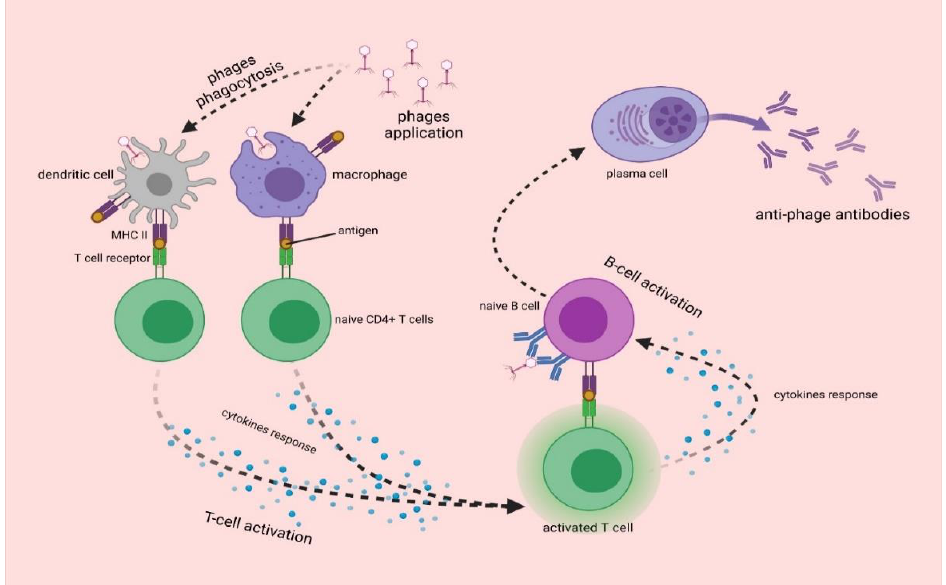
Figure 3. The synthesis of anti-phage antibodies. Upon entry into the body, bacteriophages are phagocytosed by dendritic cells and macrophages, which present phage antigen to naive CD4+ T cells. This leads to the activation of T cells, which present antigen to B cells. The differentiation of B cells results in the formation of plasma cells that produce anti-phage antibodies